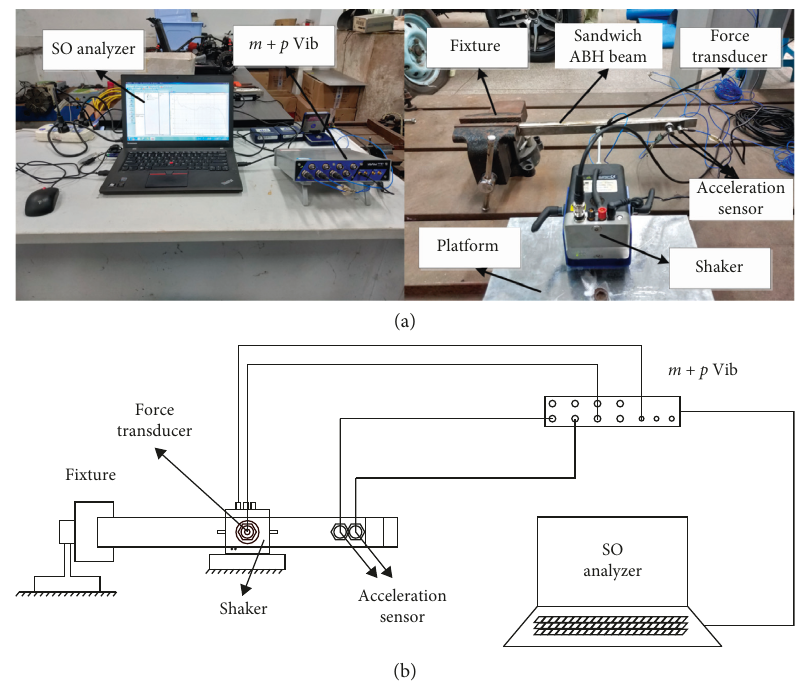
Figure 14: Experimental set-up: (a) photograph of the experiment system; (b) schematic of the experiment